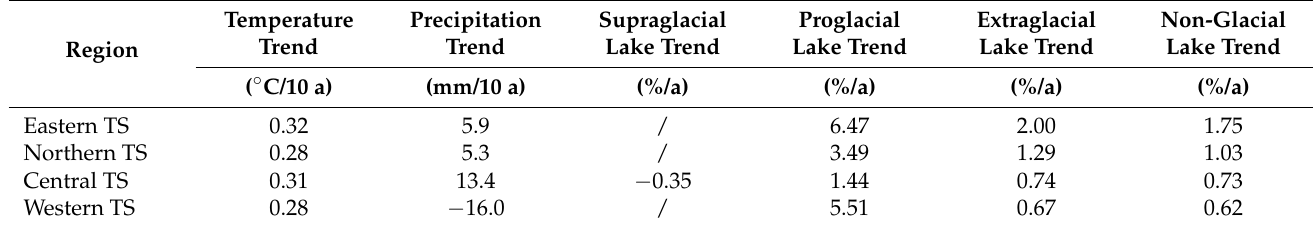
Table 4. Change rates in mean annual temperature, precipitation and the areas of different types of alpine lake from 1990 to